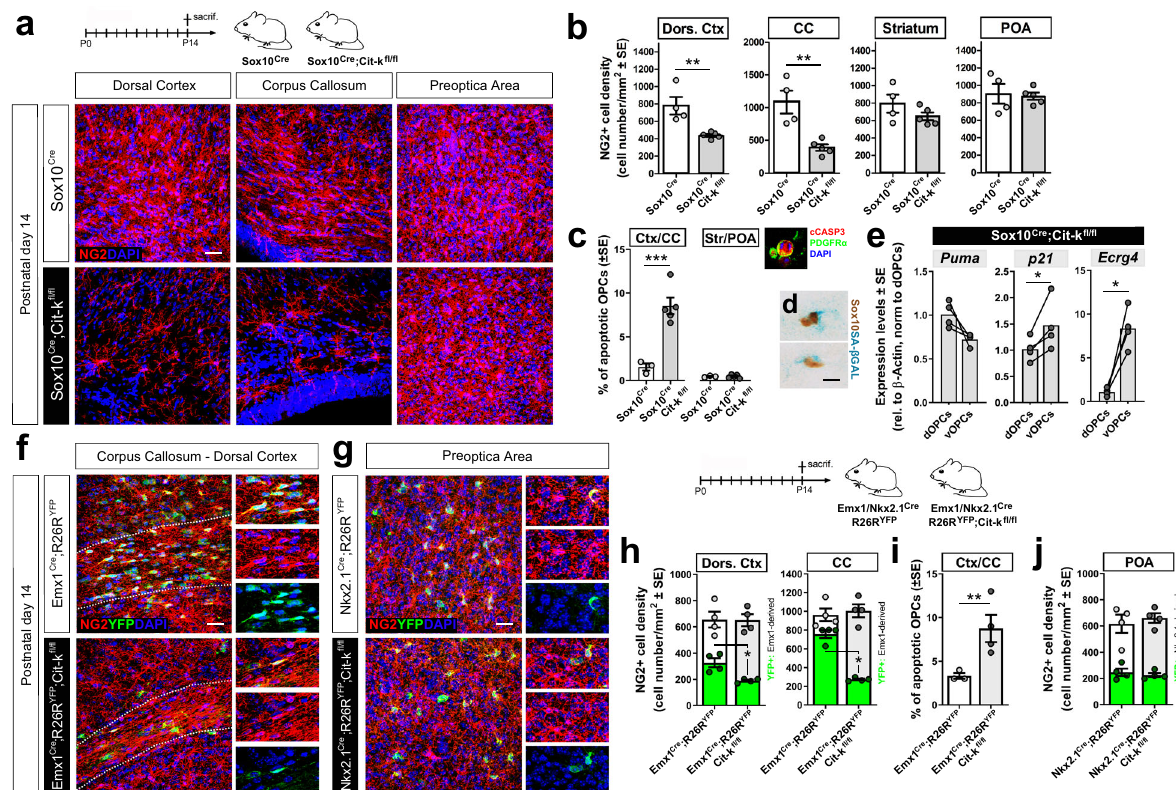
Fig. 5 Alternative fates of Cit-k KO dorsal vs. ventral OPCs are due to cell-intrinsic factors and associated with their diverse developmental origin. a NG2 + (red) cells in distinct regions of Sox10 Cre (Ctrl) vs. Sox10 Cre ;Cit-k fl / fl mouse forebrain at P14. b NG2 + cell density in the dorsal cortex, corpus callosum, striatum and preoptica area at P14 (Sox10 Cre n = 4; Sox10 Cre ;Cit-k fl / fl n = 5. Two-tailed Unpaired t -test, Dors. Ctx: P = 0.0073, t(7) = 3.741; CC: P = 0.0038, t(7) = 4.249; Str: n.s.; POA: n.s.). c Percentage of cCASP3 + OPCs in distinct regions of P14 Sox10 Cre (Ctrl; n = 3) vs. Sox10 Cre ;Cit-k fl / fl ( n = 5) mice (Chi-Square Test, Dors.Ctx/CC: P < 0.0001, χ 2 (1) = 15.98). (inset) Representative PDGFR α + (green)/cCASP3 + (red) OPC in Sox10 Cre ;Cit-k fl / fl mouse cortex. d SA- β GAL + (blue)/Sox10 + (brown) oligodendroglial cells in Sox10 Cre ;Cit-k fl / fl mouse striatum. e Expression of mRNAs coding for apoptosis- and senescence- associated proteins in dOPCs vs. vOPCs MACSorted from P10 Sox10 Cre ;Cit-k fl / fl mice (Two-tailed Paired t -test, n = 4/group; Bbc3 , n.s.; p21 , P = 0.049, t(3) = 3.204; Ecrg4 : P = 0.011, t(3) = 5.744). f NG2 + (red) cells in the CC and deep layers of the dorsal cortex of Emx1 Cre ;R26R YFP (Ctrl) vs. Emx1 Cre ;R26R YFP ;Cit-k fl / fl P14 mice. YFP (green)-positivity identi fi es cells derived from dorsal Emx1 + progenitors. g NG2 + (red) cells in the preoptic area of Nkx2.1 Cre ;R26R YFP (Ctrl) vs. Nkx2.1 Cre ;R26R YFP ;Cit-k fl / fl P14 mice. YFP (green)-positivity identi fi es cells derived from ventral Nkx2.1 + progenitors. h NG2 + and NG2 + /YFP + cell density in the dorsal cortex and corpus callosum of P14-P16 Emx1 Cre ;R26R YFP (Ctrl, n = 4) vs. Emx1 Cre ;R26R YFP ;Cit-k fl / fl ( n = 4. Two- tailed Mann – Whitney U-test, Dors. Ctx: tot: n.s.; YFP + : 0.028; CC: tot: n.s.; YFP + : 0.028). i Percentage of cCASP3 + OPCs in Dors.Ctx/CC of P14-P16 Emx1 Cre ;R26R YFP (Ctrl, n = 3) vs. Emx1 Cre ;R26R YFP ;Cit-k fl / fl ( n = 4) mice (Chi-Square Test: Dors.Ctx/CC: P = 0.0038, χ 2 (1) = 8.362). j NG2 + and NG2 + / YFP + cell density in the preoptica area of P14-P16 Nkx2.1 Cre ;R26R YFP (Ctrl, n = 4) vs. Nkx2.1 Cre ;R26R YFP ;Cit-k fl / fl ( n = 4. Two-tailed Mann – Whitney U-test, tot: n.s.; YFP + : n.s.). Data in b , c , h , i , j are mean ± SE. In e lines connect paired samples (i.e., dOPC and vOPC samples from the same mouse). DAPI (blue) in a , f , g counterstains cell nuclei. Scale bars: 30 µ m in a , f , g ; 10 µ m in d . CC corpus callosum, Ctrl control, Dors. Ctx. dorsal cortex, POA preoptica area, P postnatal day. *** P < 0.001; ** P < 0.01, * P < 0.05. Source data are provided as a Source Data fi le.